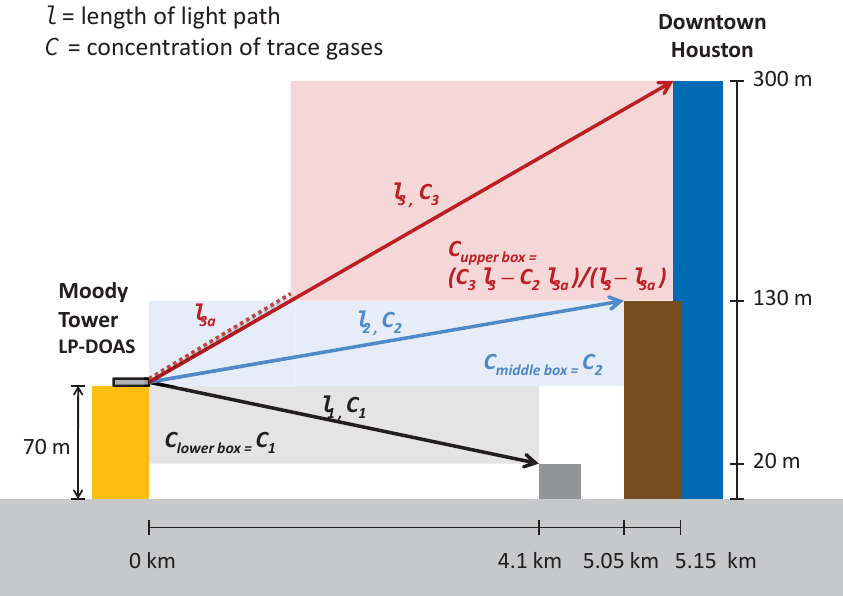
Fig. 1. Schematic figure of the setup of UCLA’s LP-DOAS during SHARP 2009, showing the three LP-DOAS light paths and the height intervals for which concentrations were retrieved.